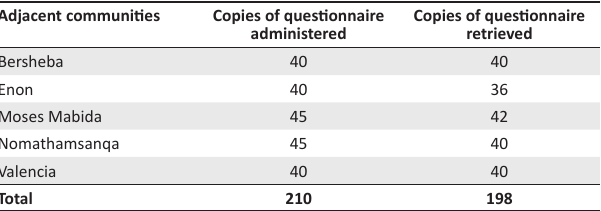
TABLE 2: Sampling procedure for